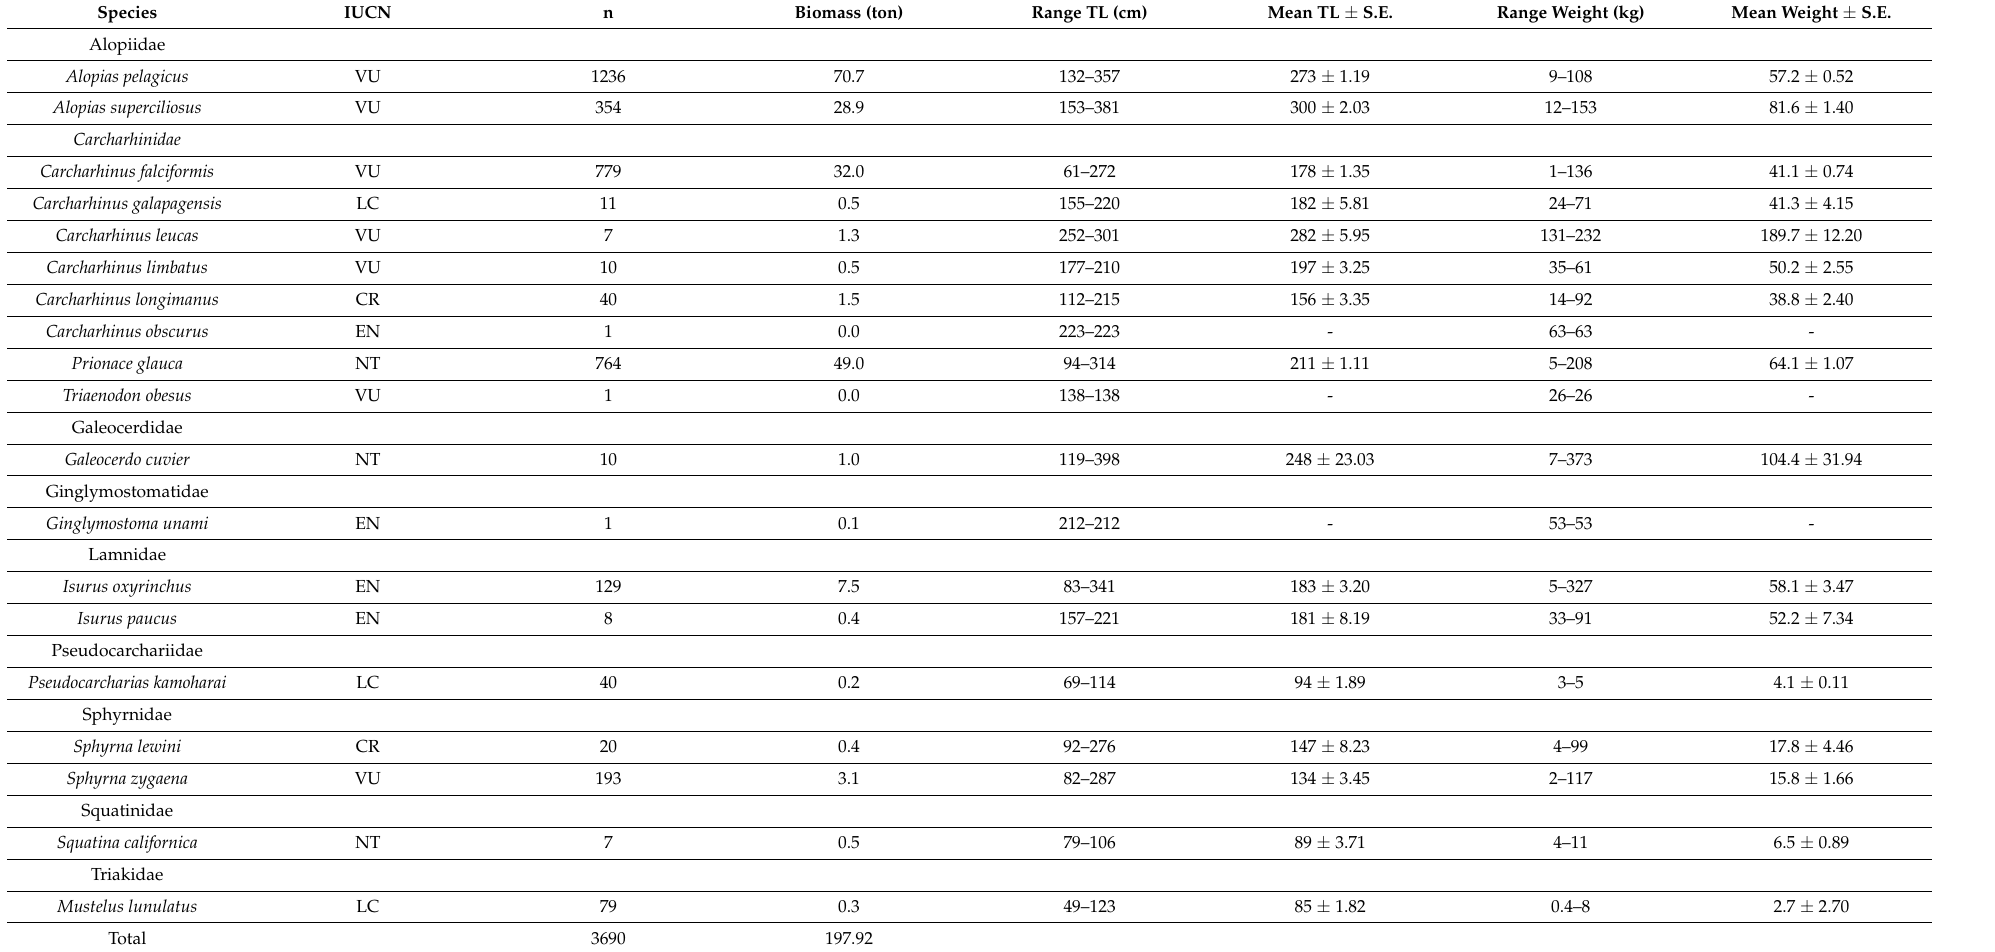
Table 3. Descriptive statistics of shark species measured during the year 2019 in Manta. The meaning of the abbreviations of the categories of the Red List of Threatened Species of the International Union for the Conservation of Nature (IUCN): least concern (LC), near threatened (NT), vulnerable (VU), endangered (EN) and critically endangered